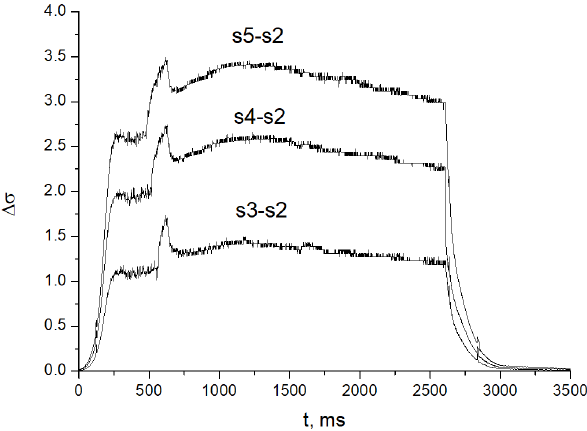
Figure 10. Time difference signal of the SmS-based sensor conduc- tivity change for three different concentrations of toluene vapor in atmospheric air (heating and cooling).